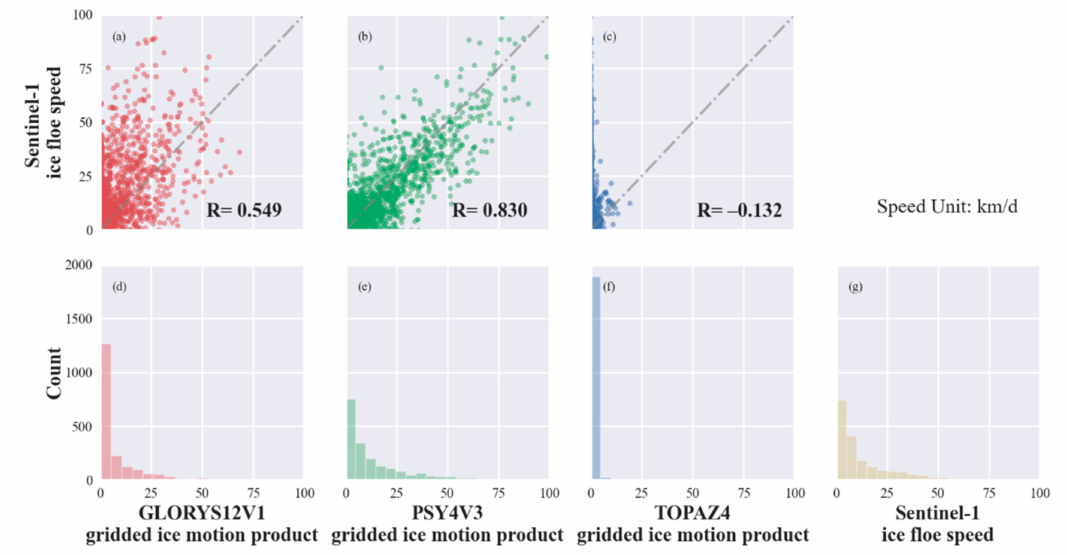
Figure 6. ( a – c ) Scatter plots of the ice floe speed calculated from Sentinel-1 versus the speed obtained from sea ice motion products. The diagonal dashed lines are the 1:1 lines. ( d – g ) Distributions of the ice motion derived from the three products and the corresponding data from the Sentinel-1 images.